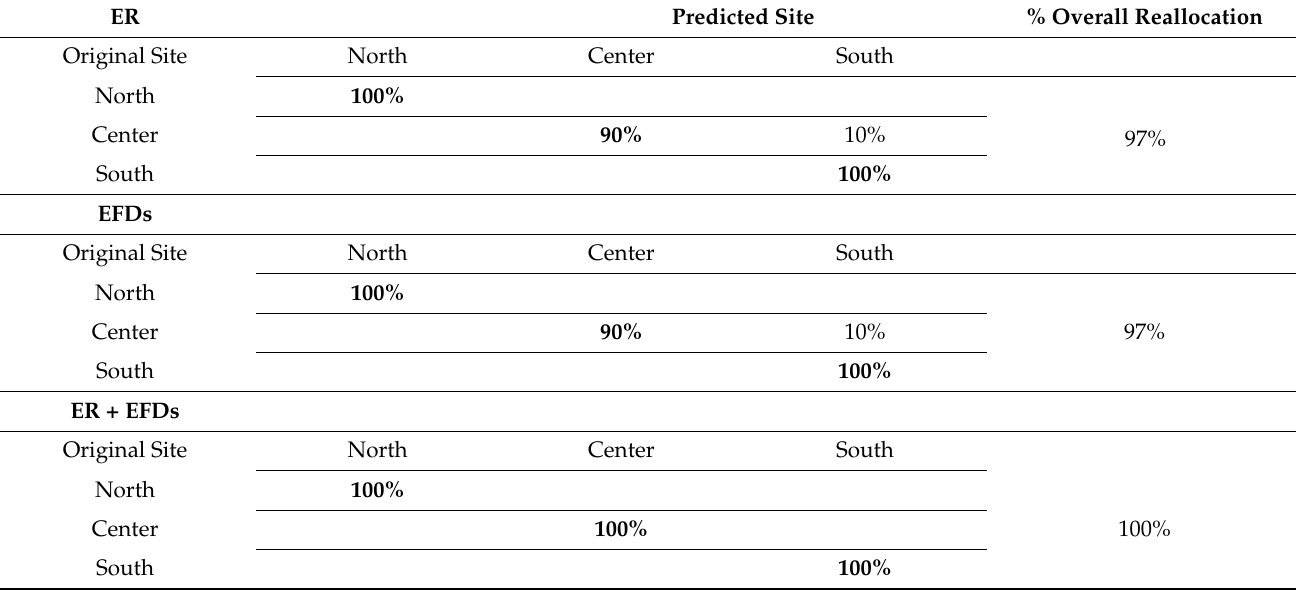
Table 4. Jackknife re-classification matrix based on Element:Ca ratios (ER), elliptical Fourier descrip- tors (EFDs) and both methodologies (ER + EFDs) for the North, Center and South